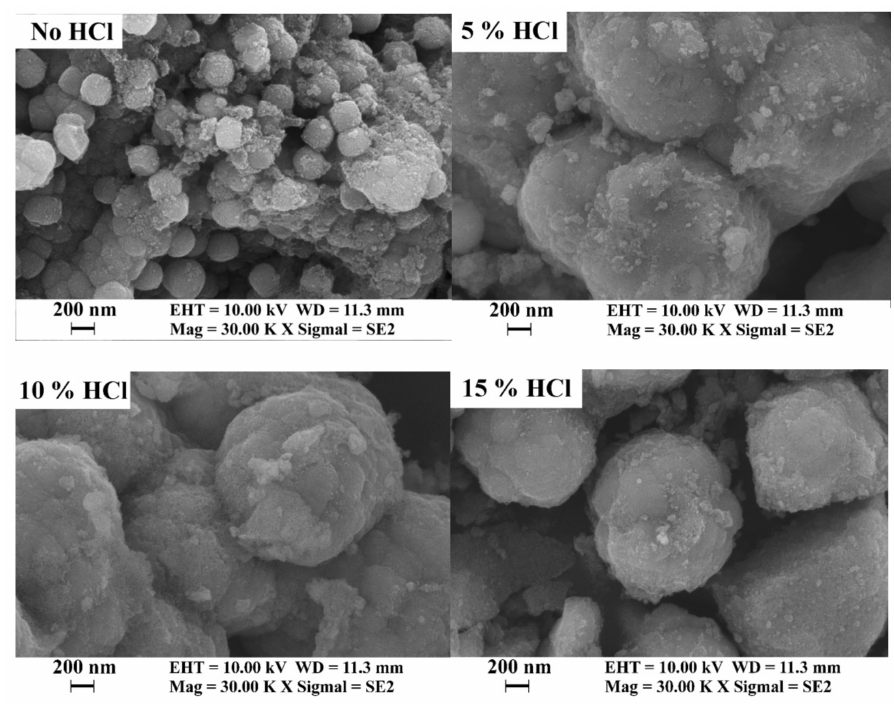
Figure 8. Effect of added HCl on the changing trend of impurities in TiO 2